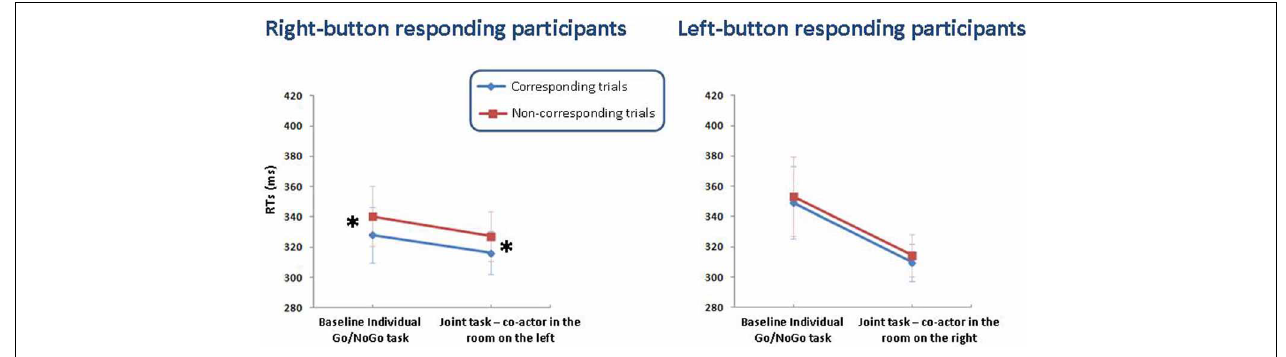
FIGURE 4 | Means ( ± S.E.M.s) of correct RTs for right- and left-button responding participants in Experiment 3. RTs are plotted as a function of task (baseline vs. joint task) and spatial correspondence (corresponding vs.